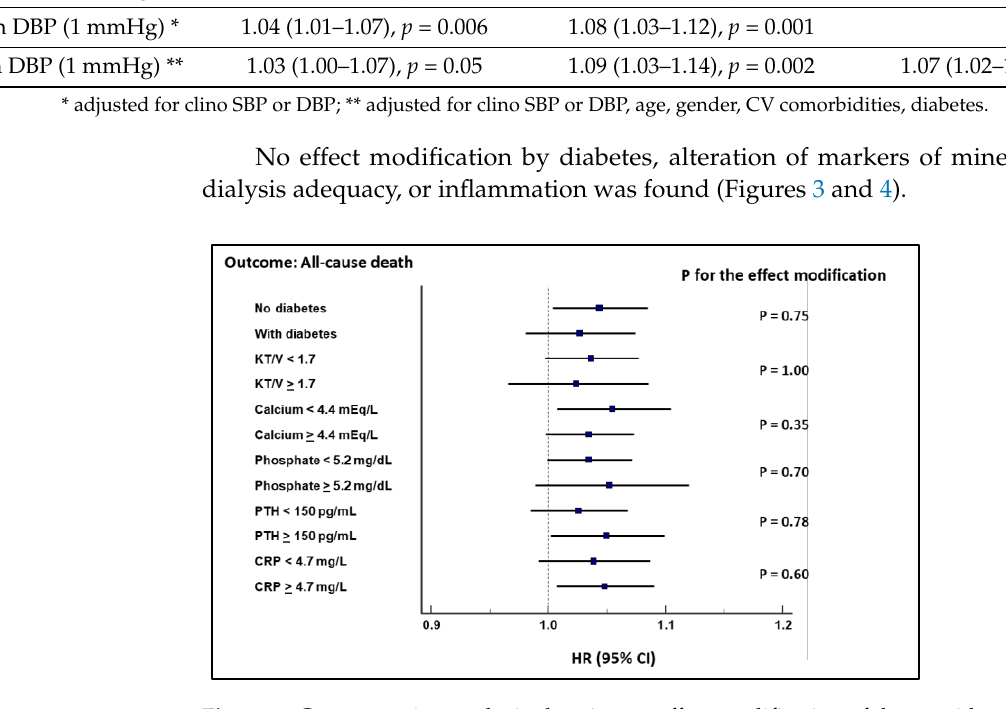
Table 2. Survival analysis showing the association between changes in DBP and all-cause and CV death. All-Cause Death